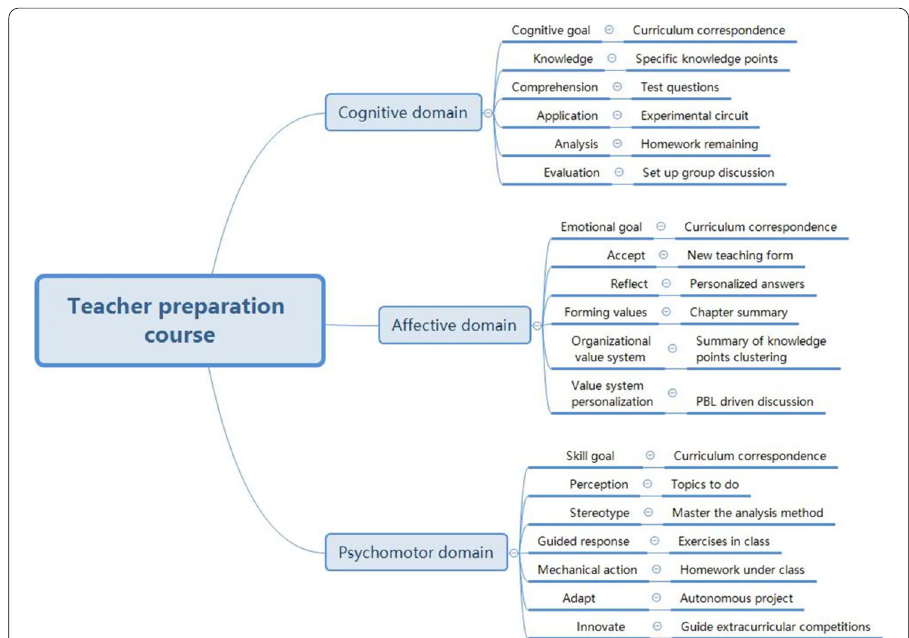
Fig. 2 The preparation of analog circuit course based on Bloom’s